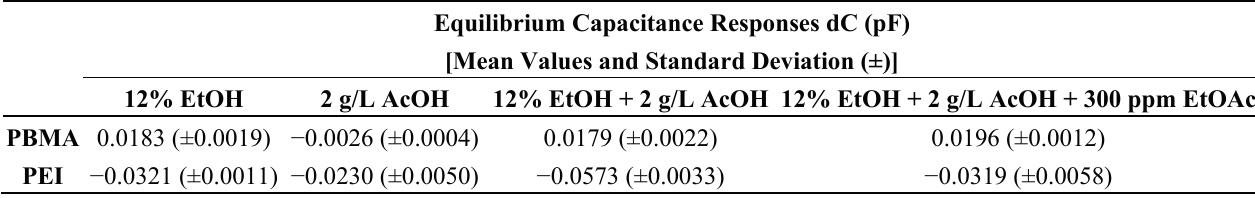
Table 2. Equilibrium Responses of two representative polymer coated sensors upon exposure to the headspace of several standard pure or contaminated with controlled concentrations of ethyl acetate and acetic acid in ethanol